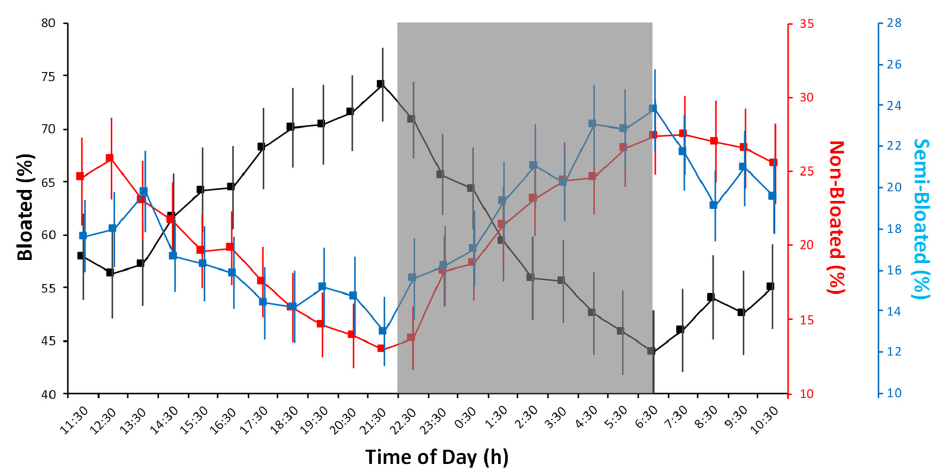
Figure 10. Waveform analysis outputs as averaged percentages for colony surface with polyps in full extrusion (bloated) or full retraction (non-bloated) as well as the intermediate condition (semi-bloated) are reported with the standard deviation. A marked unimodal increase in bloated status (i.e., possibly corresponding to filter feeding activity) is evident in antiphase with non-bloated and semi-bloated statuses (see the MESOR threshold values in Table 3). On should notice that waveforms Y -axes have different scales to make time series pattern as visually comparable. The gray shaded area represents the hours of darkness.